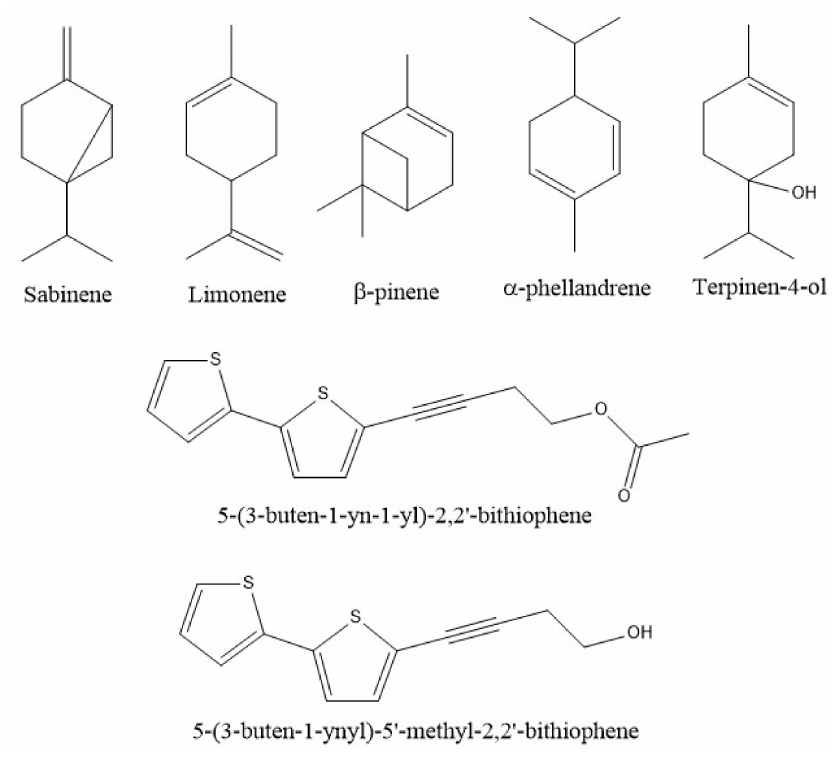
Figure 1. Major components isolated from species of the genus